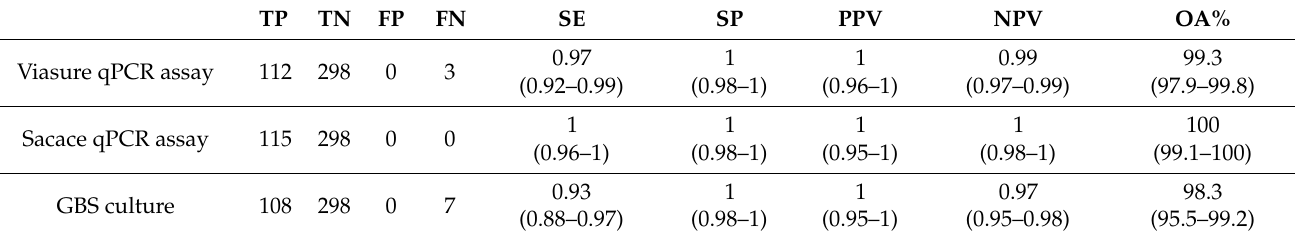
Table 3. Clinical validation results (95% confidence interval) after the study of the discordant